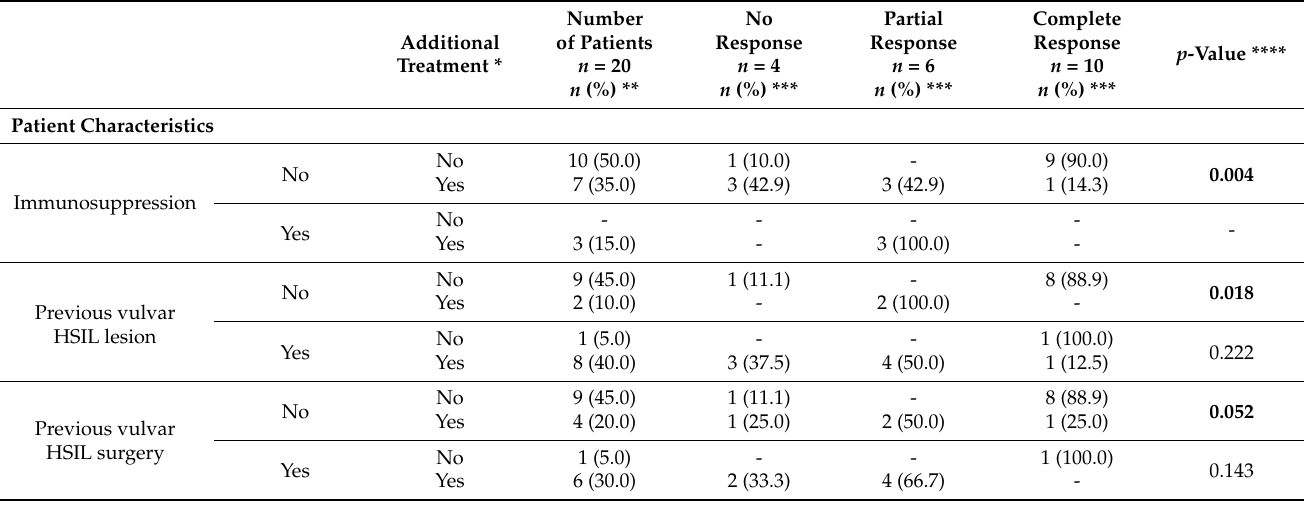
Table 5. Patient and lesion characteristics in cases with and without additional treatment after treatment with